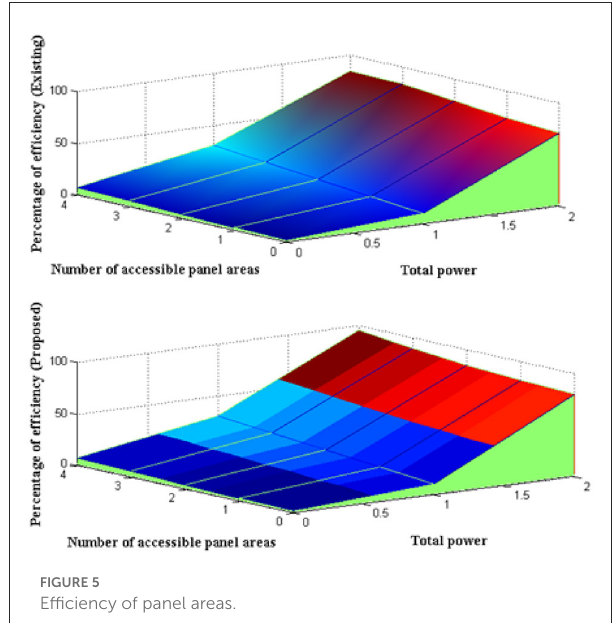
FIGURE5 Efficiency of panel areas.